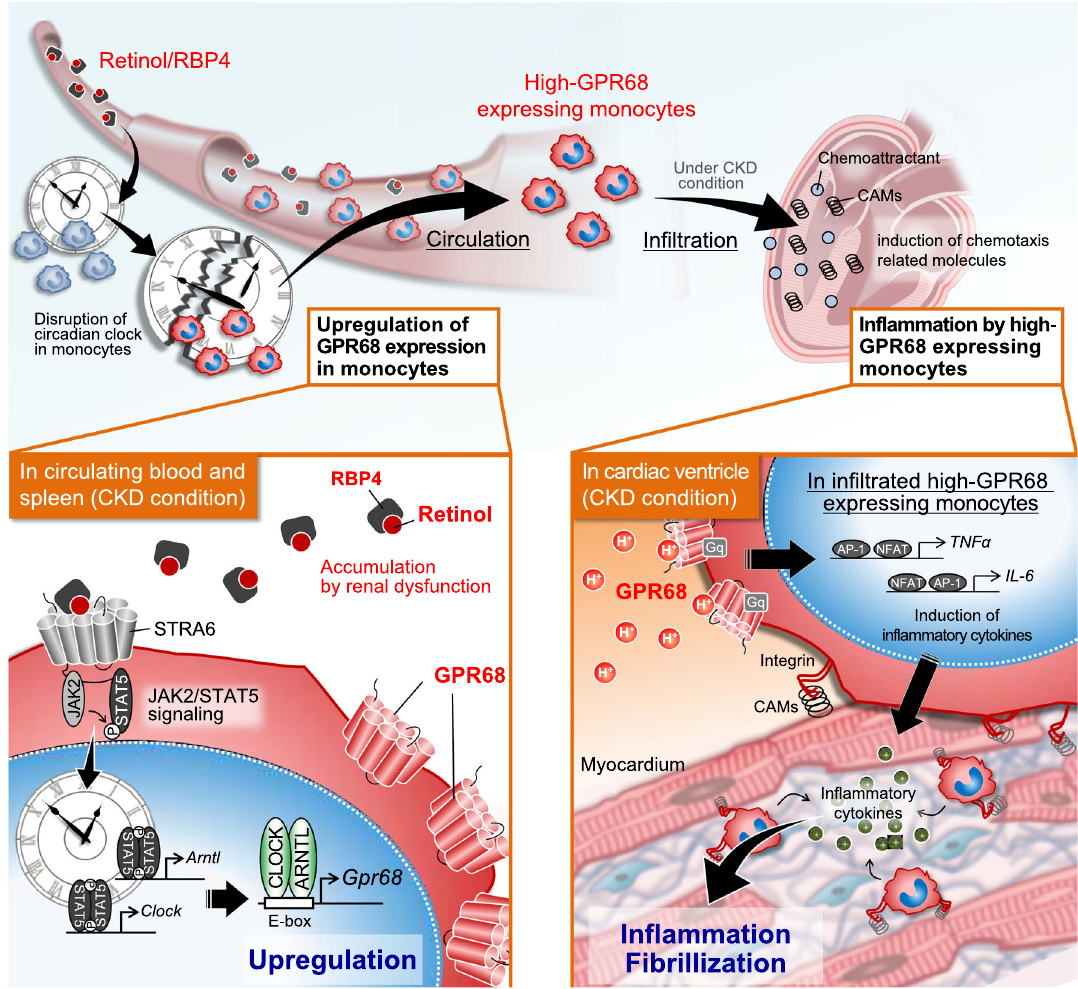
Fig. 9 Schematic diagram indicating the retinol/RBP4-induced expression of GPR68 in circulating monocytes and their pathological role in the CKD- induced cardiac in fl ammation and fi brosis. Serum levels of retinol and RBP4 were increased during chronic renal failure. The retinol-bound RBP4 activates JAK2/STAT5 signaling in circulating monocytes through STRA6 and induces the expression of GPR68 via activation of CLOCK/ARNTL. The high-GPR68- expressing monocytes in fi ltrate into the heart potential for producing in fl ammatory cytokines and their cardiac in fi ltration exacerbates in fl ammation and fi